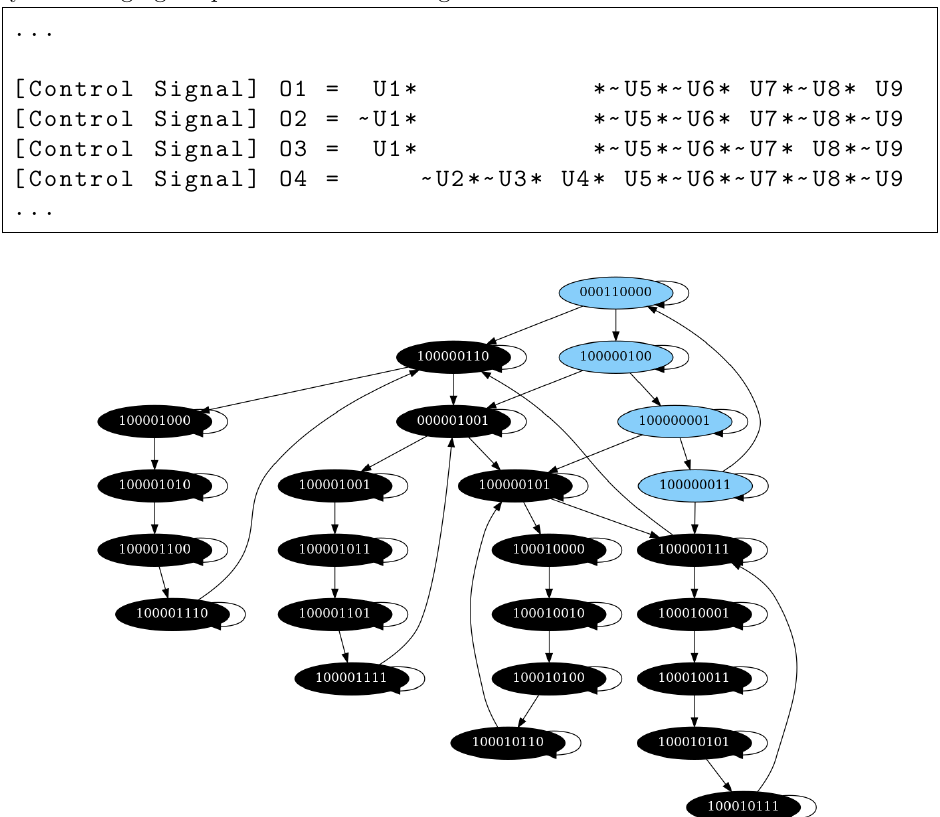
Figure 11: State transition graph of UART IP core obfuscated with Active Hardware Metering . Tarjan’s algorithm splits all states in 2 strongly connected components: black hole cluster states (marked in black), and original FSM states (marked in blue). Input values for each state transition are deliberately left out for